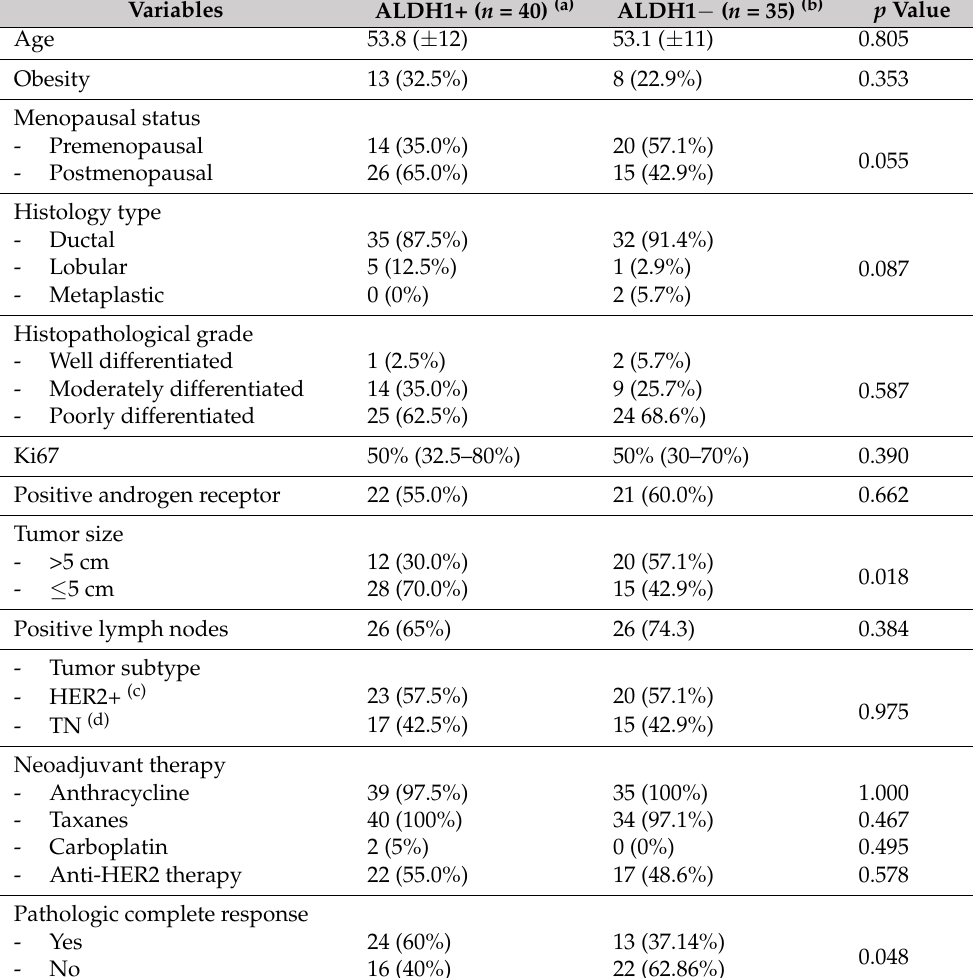
Table 2. Relationship between ALDH1A1 expression and clinicopathological characteristics in breast cancer